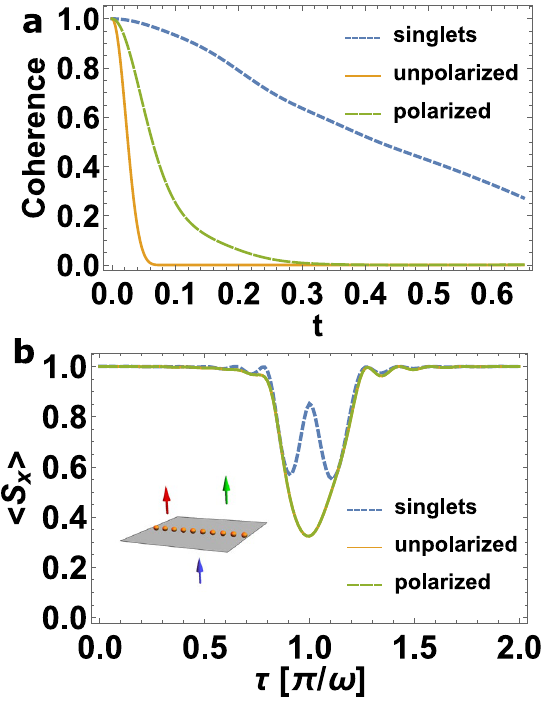
Figure 3. ( a ) The coherence of the central spin is plotted as a function of time for three different initial states of the spin-bath. ( b ) The central spin transition conditioned on its coupling to three different nuclear spin species that have Larmor frequencies ω , ω 1 = ω + ε , ω 1 = ω − ε (we chose ε = ω /10) is shown as a function of the interrogating time τ , for three different initial states of the strongly interacting spin-bath ( ω ). Clearly, when the spin bath is initialized into the singlet paired state, the two farther nuclear spins are well resolved. The inset displays the spin configuration with different spin